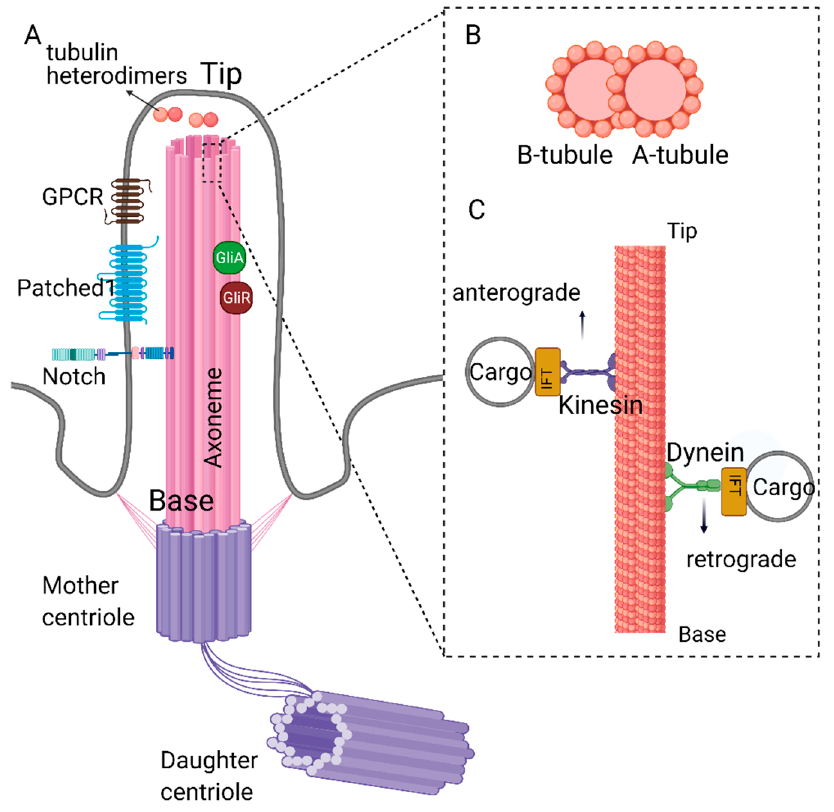
Figure 1. Structure of primary cilia. ( A ) Primary cilium is nucleated from the mother centriole of the basal body. Axoneme consists of 9 microtubule doublets formed by α and β tubulin heterodimers. ( B ) Cross-section of complete A- and partial B-tubules. ( C ) Dynein and kinesin proteins carrying cargo on the axoneme. Retrograde movement (from tip to the base) is carried out by dynein proteins, whereas kinesin proteins carry out anterograde movement (from base to the tip). Kinesin and dynein proteins are essential for the assembly and disassembly of the primary cilium as they carry building blocks or the depolymerizing agents along the axoneme. Created with BioRender.com.